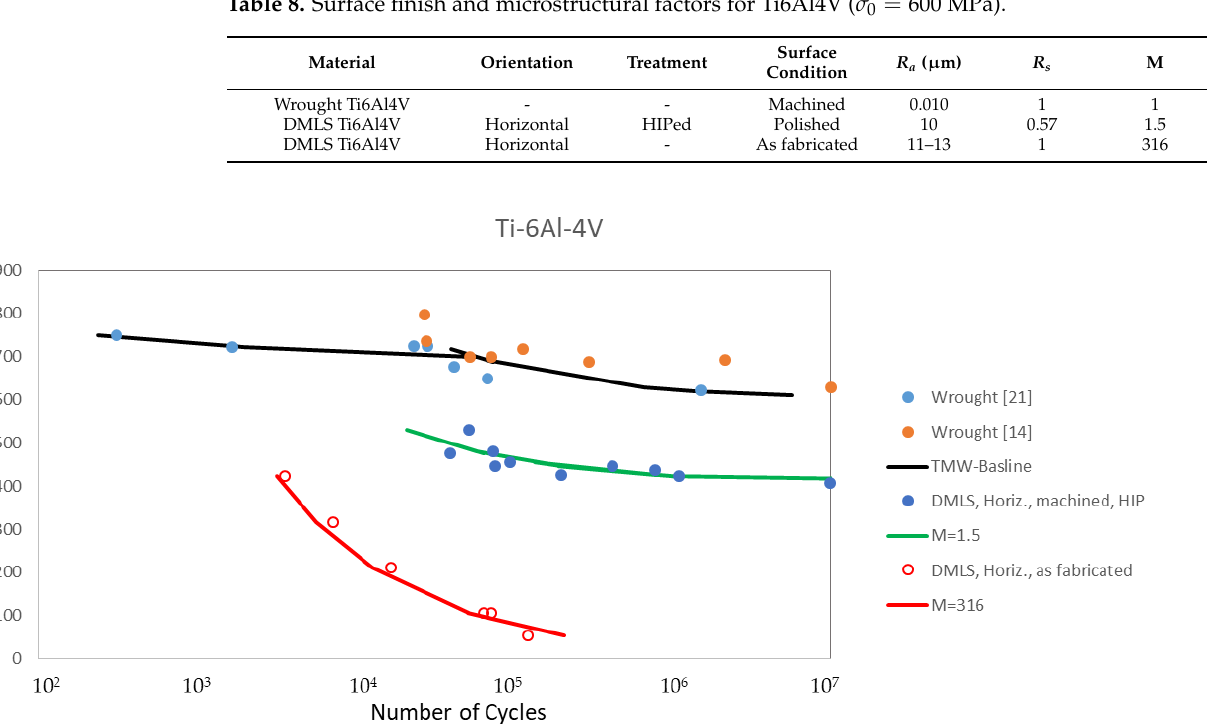
Table 7. Fatigue test results of wrought Ti-6Al-4V with the machined surface under axial loading (test information and data taken from [21]).